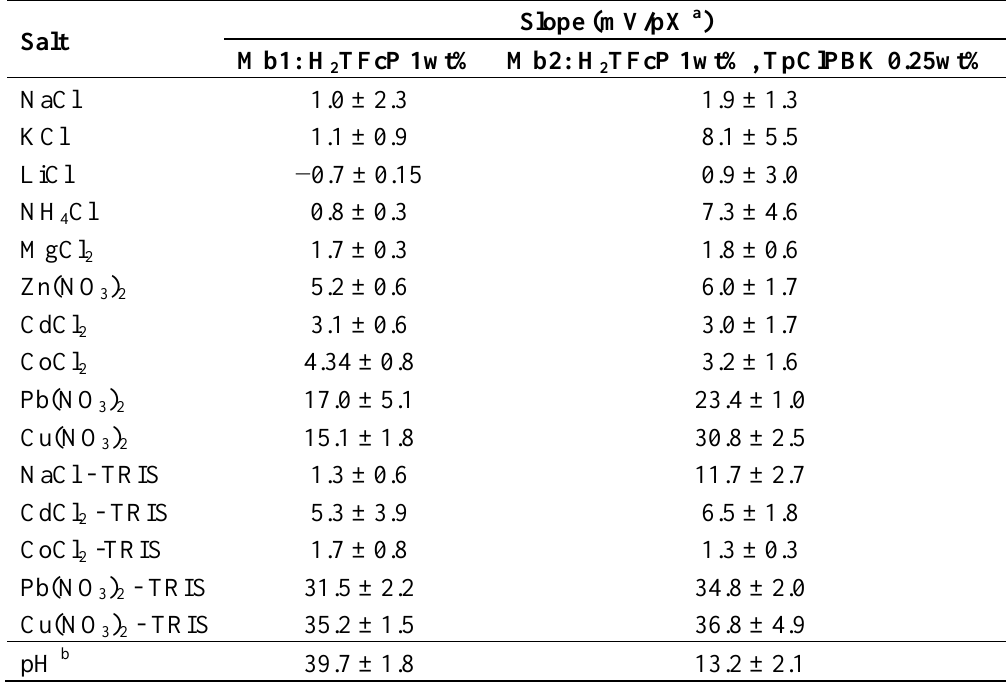
Table 1. Potentiometric response slopes of the H analytes in individual